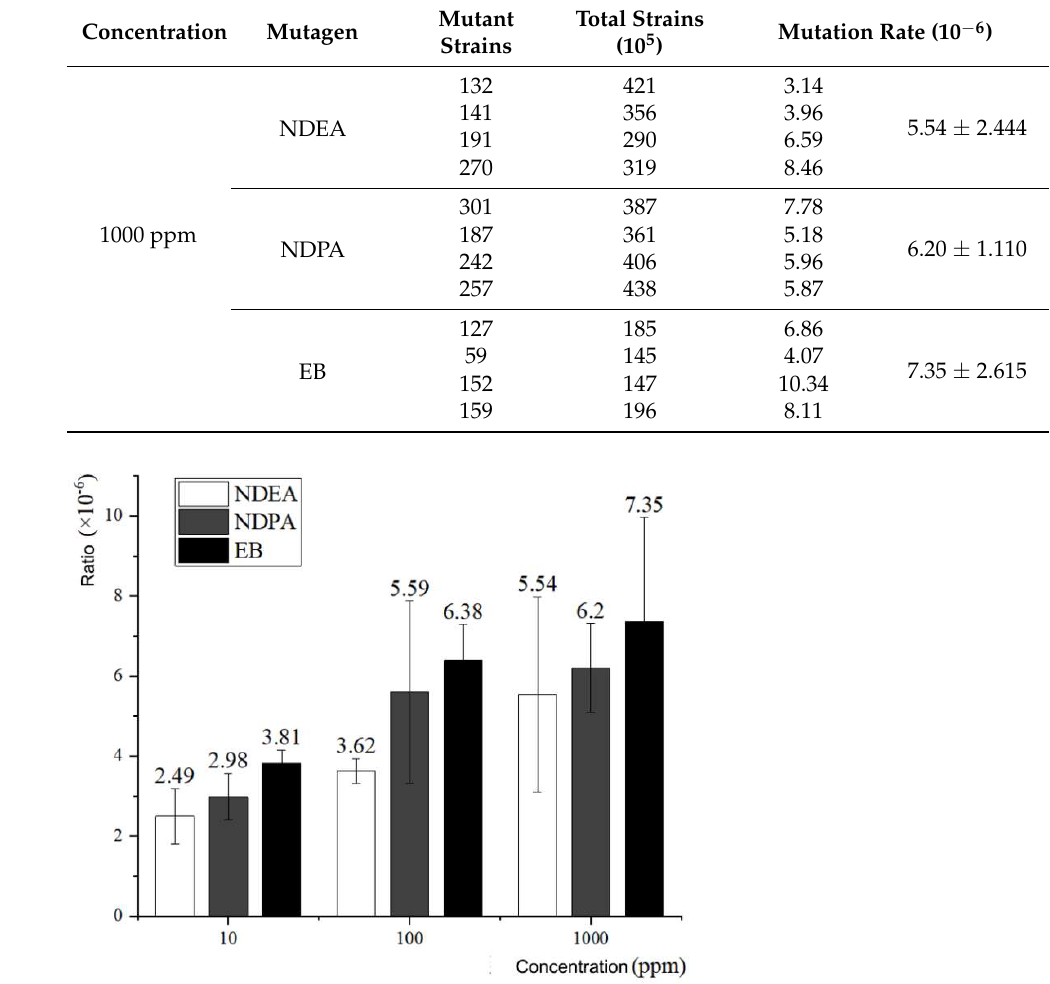
Figure 6. Comparison of rpsL mutation rates induced by NDEA, NDPA, and EB in the RCA reaction.